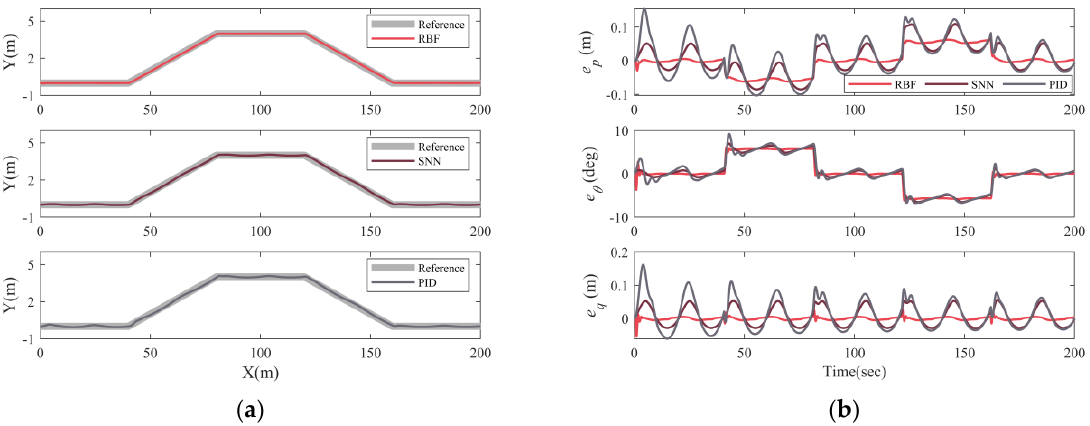
Figure 8. Comparison of results of different control algorithms by tracking a DLC path: ( a ) trajectory and ( b ) tracking errors.